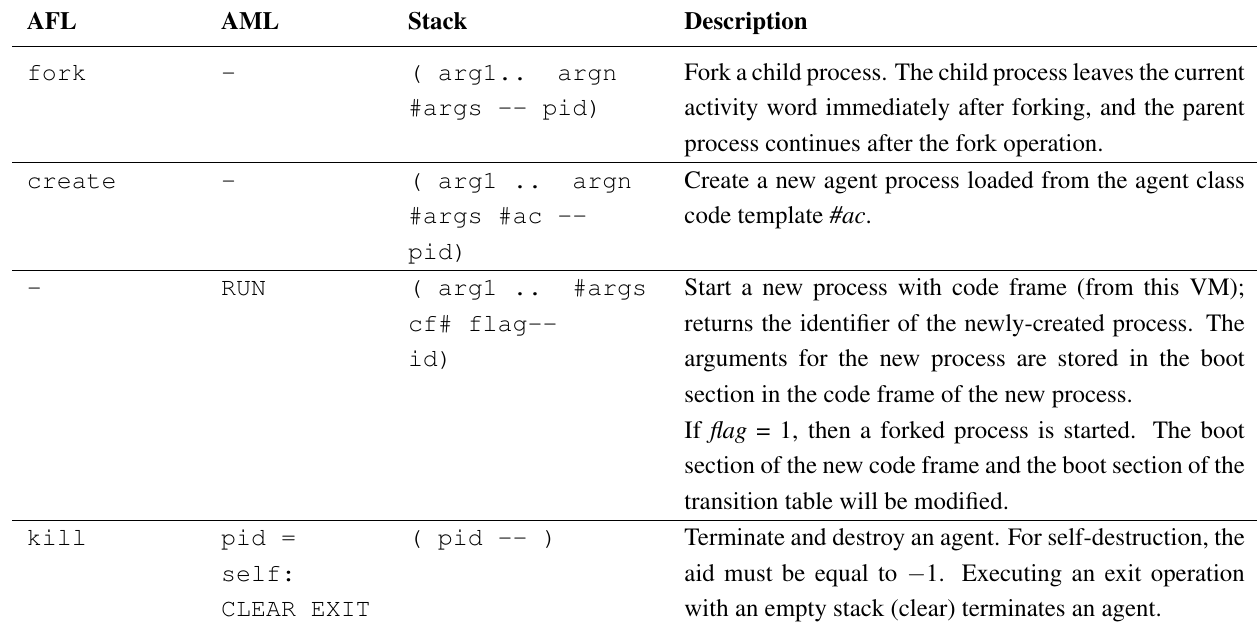
Table 3. AFL/AML agent creation and destruction